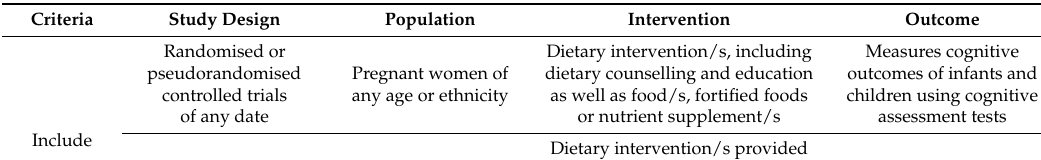
Table 1. Inclusion and exclusion criteria for selecting